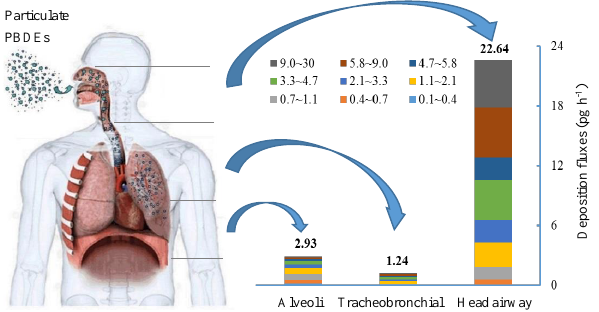
Figure 6. Deposition fluxes of size-resolved particulate PBDEs in the human respiratory tract.